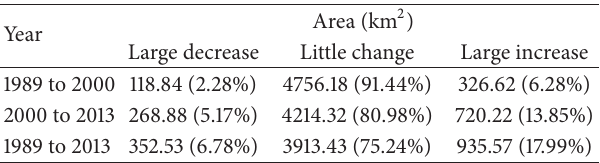
Table 4: The area of land that followed the three LST change trends during different